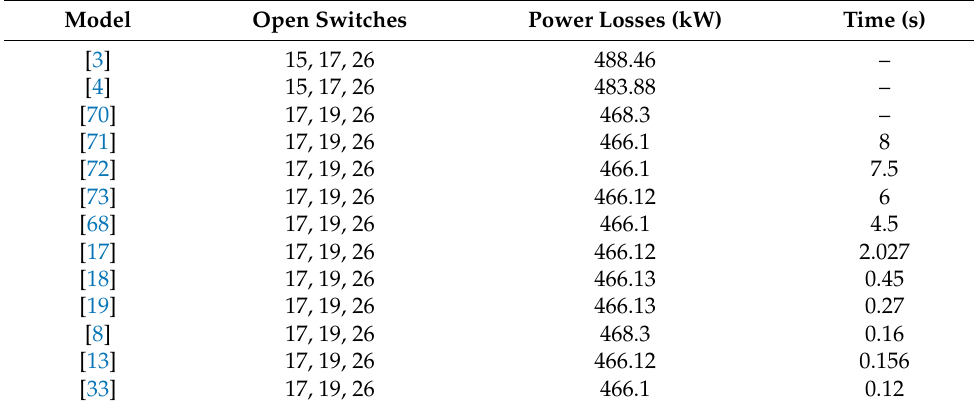
Table 11. Comparative analysis of the 16-bus test system.